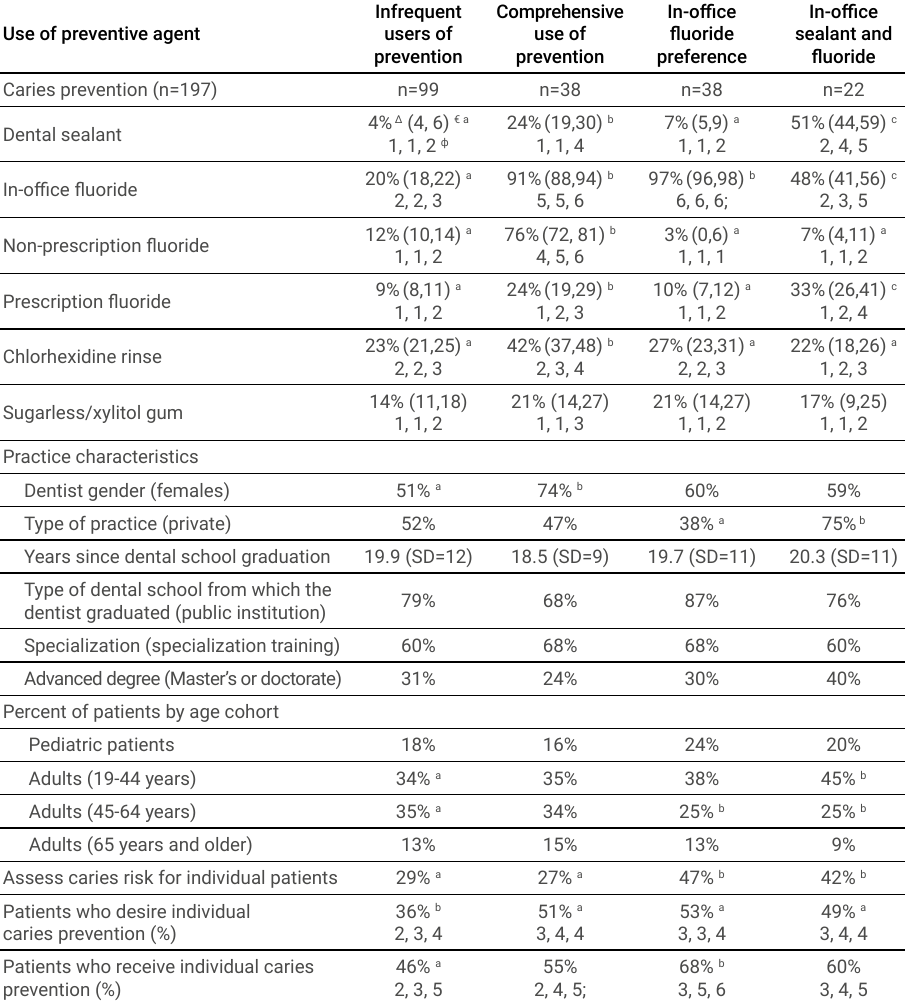
Table 5. Use of preventive agents for adult patients by preventive subgroups and dentist’s, patient’s, and practice’s